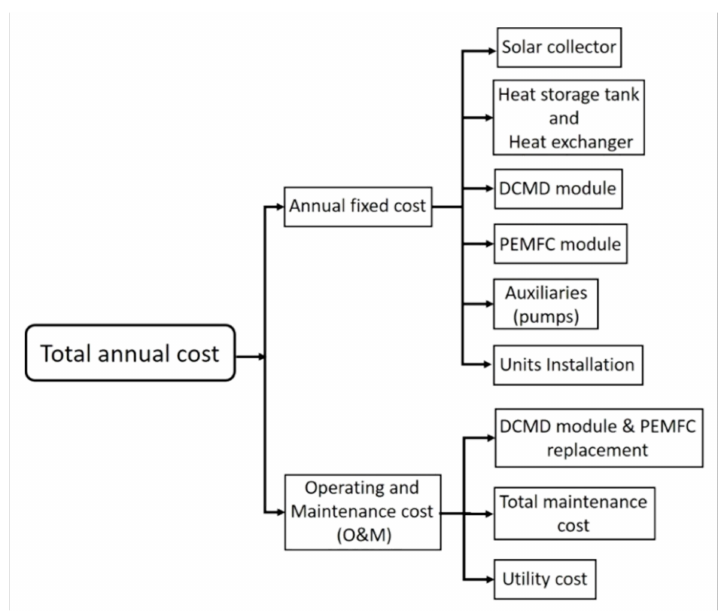
Figure 5. The costs for economical cost